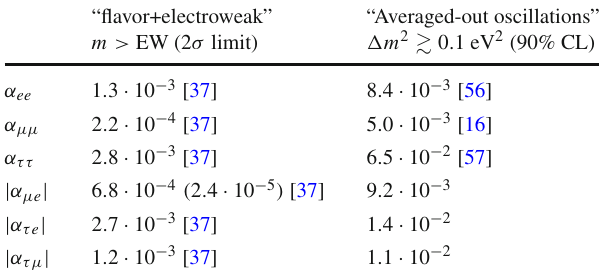
Table 1 Current upper bounds on the α parameters. The bounds in the middle column (shown at 2 σ , 1 d.o.f.) apply for (cid:8) m 2 (cid:3) 100 eV 2 and are taken to a global fit to flavor and electroweak precision observables from Ref. [37]. The bounds in the right column (shown at 90% CL, for 1 d.o.f.) apply for (cid:8) m 2 (cid:3) 0 . 1 eV 2 and come from neutrino